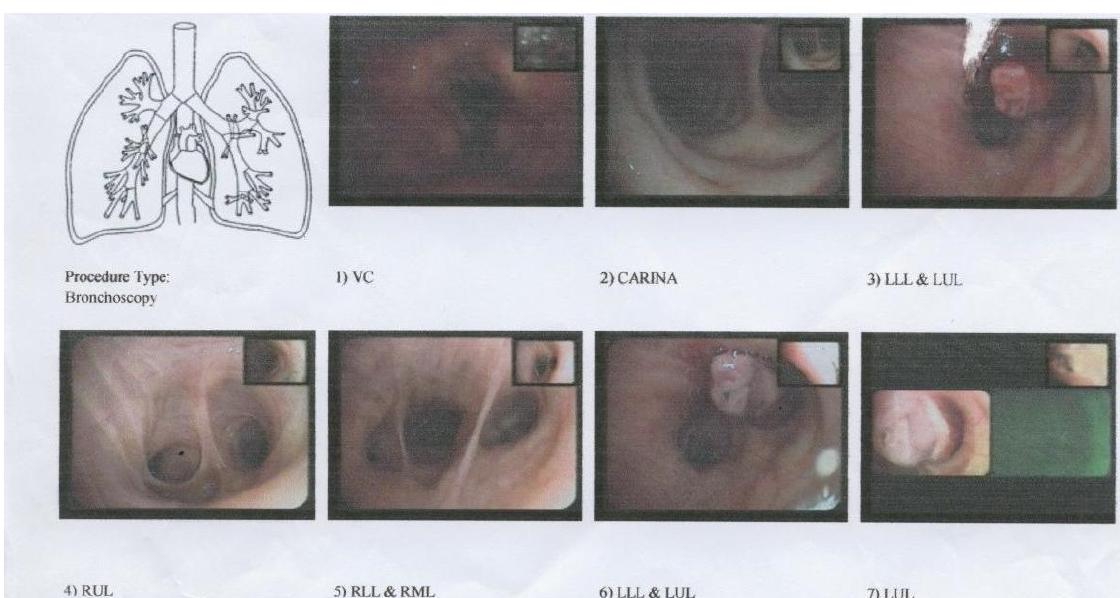
Figure 1 . Bronchoscopy of protruded mass arising from superior segmental bronchus in lower lobe